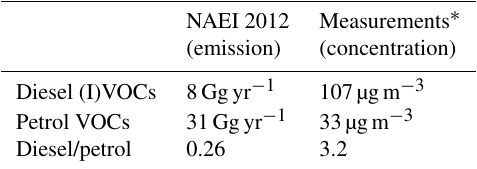
Table 2. Comparison of diesel and petrol NMVOCs in the UK National Atmospheric Emissions Inventory (NAEI) with the urban background ambient concentrations measured during the ClearfLo winter intensive observation period in London.